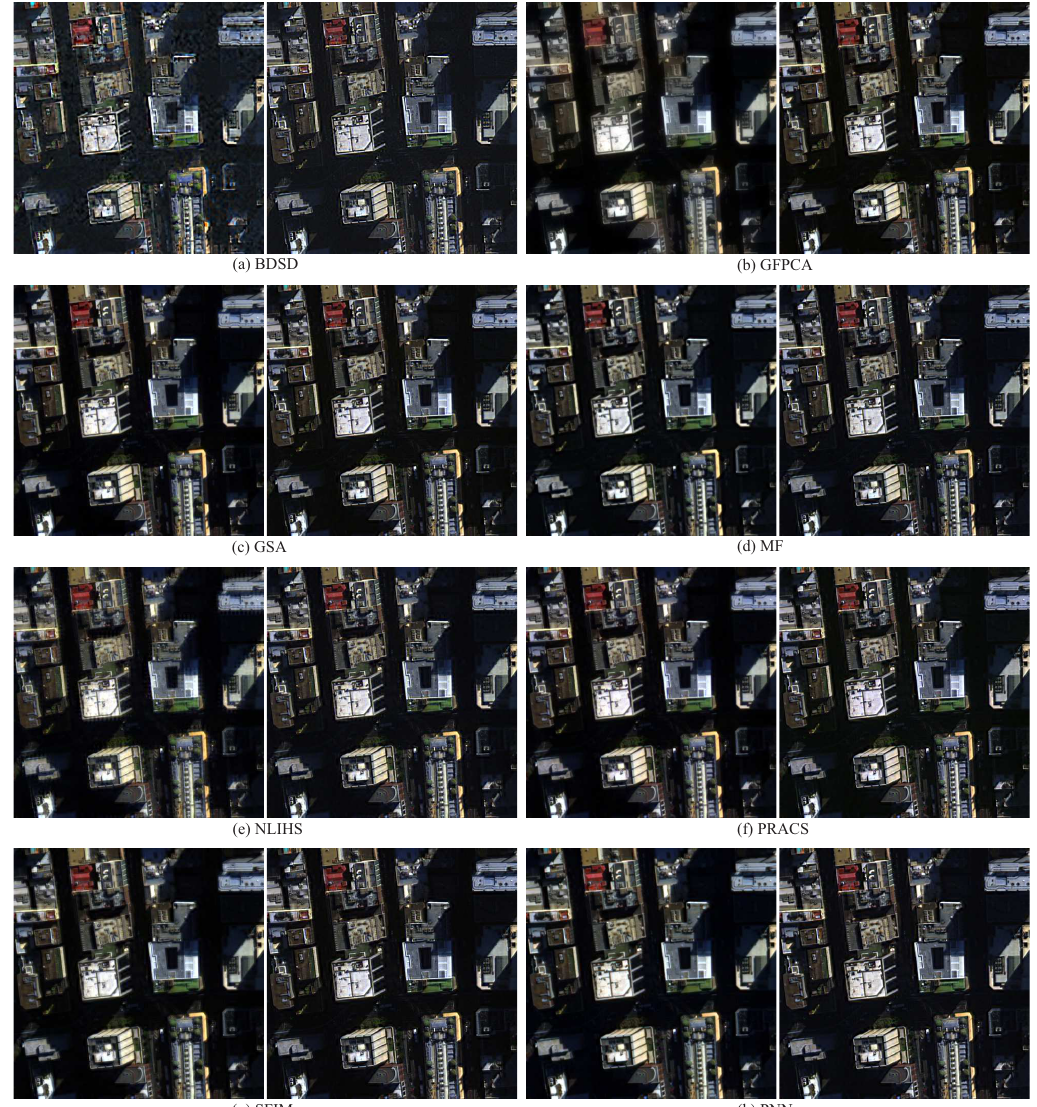
Figure 3. Visual comparison of the fused images obtained by eight methods with and without the proposed EBP as postprocessing on the WorldView-2 dataset, ( a ) BDSD; ( b ) GFPCA; ( c ) GSA; ( d ) MF; ( e ) NLIHS; ( f ) PRACS; ( g ) SFIM; ( h ) PNN. In contrast, the results with EBP postprocessing (on the right side of each subfigure) have more spatial details and more pleasant colors than those of without EBP (on the left side of each subfigure). Best zoomed in on screen for visual comparison